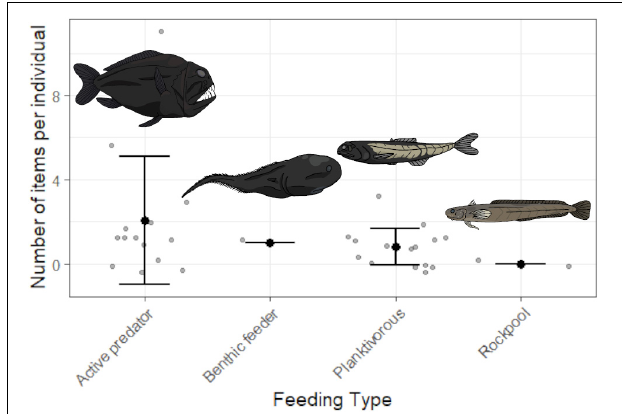
FIGURE 3 | The number of fibers ingested by four distinct groups of species separated by their feeding type. Gray points represent data for individual fish whilst black dots are the mean with whiskers of ± one standard deviation. Active predators include: Borostomias elucens , Anoplogaster cornuta , Chauliodus sloani , Sigmops elongatus , Opostomias micripnus, Idiacanthus atlanticus ; benthic feeders: Macrouroides inflaticeps ; planktivorous species: Ectreposebastes imus , Lampanyctus australis , Argyropelecus gigas , Melanonus zugmayeri , Snyderidia canina , Serivomer beanii ; non-mesopelagic species collected from rockpools or surface waters: Gaidropsarus novaezealandiae , Patagonotothen guntheri